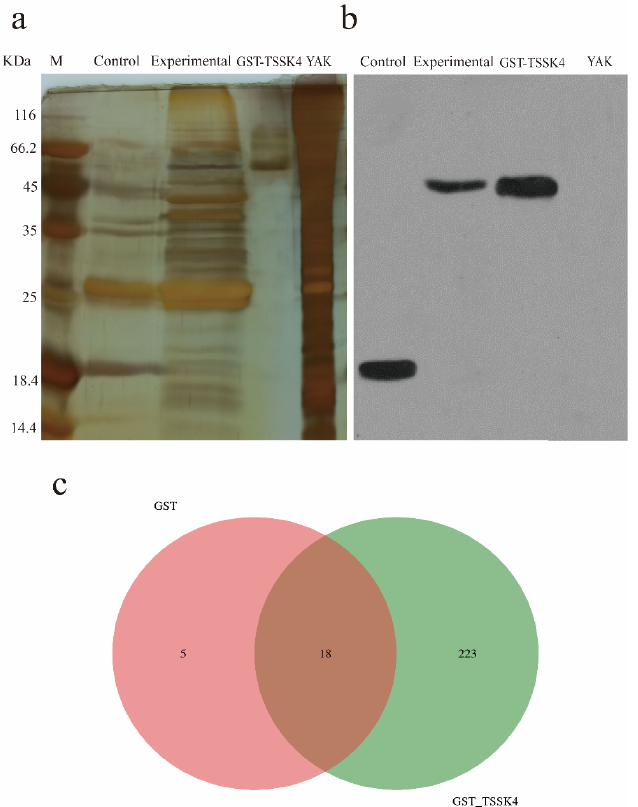
Figure 2. The results of the GST pull-down and LC–MS/MS mass spectrometry identification. ( a ) The results of the silver staining. Note: The control group and the experimental group were loaded with a 20 µL sample, GST-TSSK4, yak quantitative 2 µg. ( b ) The results of the GST antibody test. The control and the experimental groups were loaded with a 20 µL sample, GST-TSSK4, yak loaded with 50 ng, GST antibody was diluted at 1:50,000, and hypersensitivity was exposed for 2 min. ( c ) IP: Venn diagram of the IgG differential